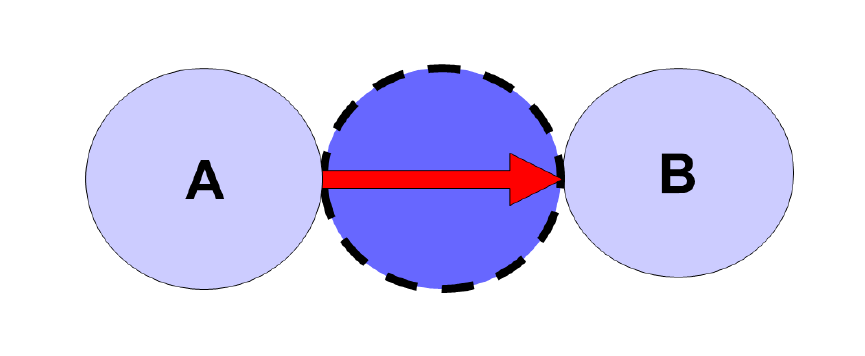
Figure 3 - PATH is a basic idea of the instrumental case (spatial image